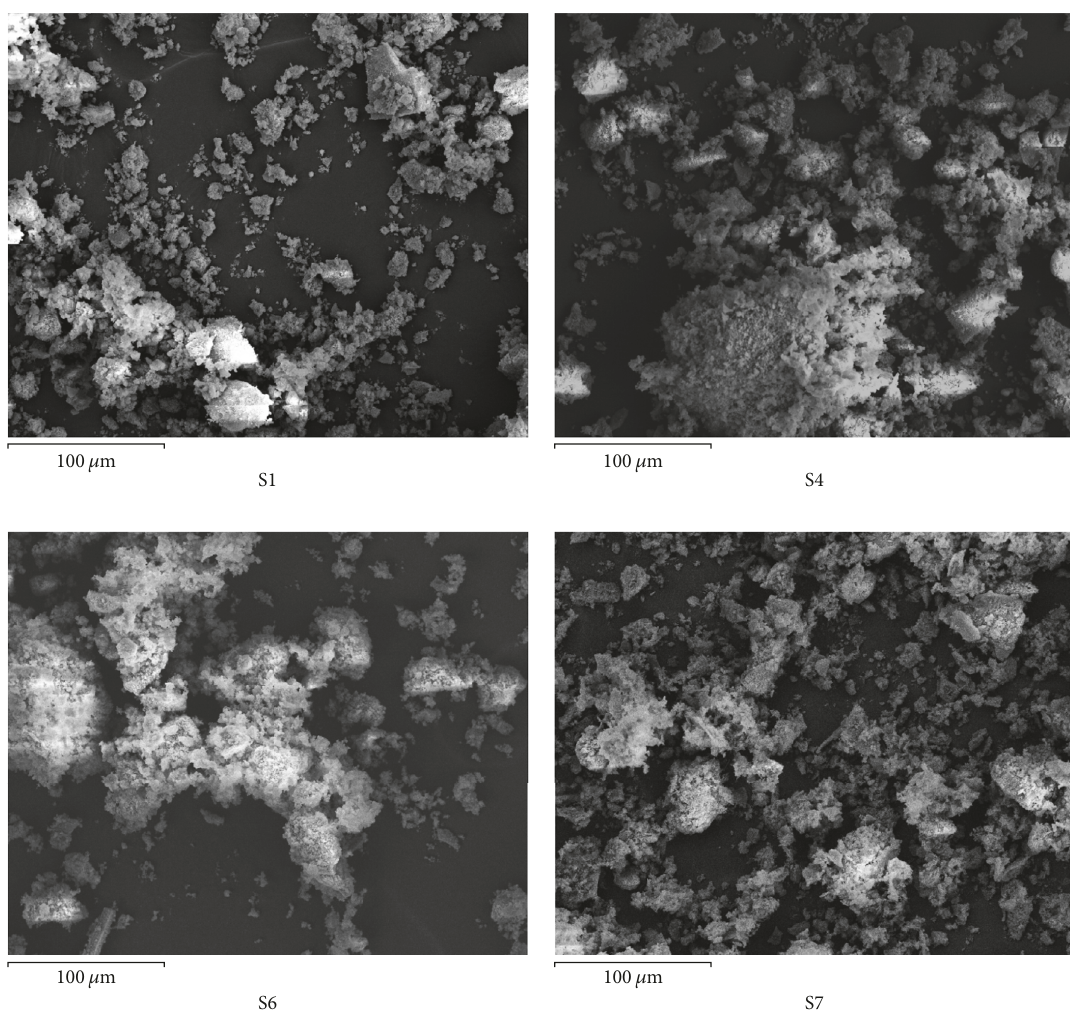
Figure 4: SEM images for S1, S4, S6, and S7